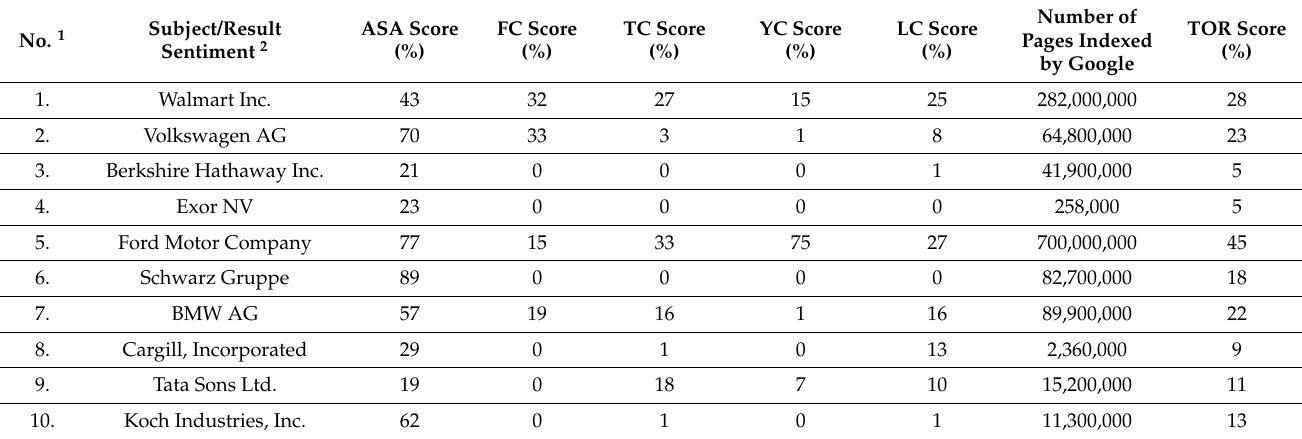
Table 2. Overall (Total) online reputation- Parent companies.